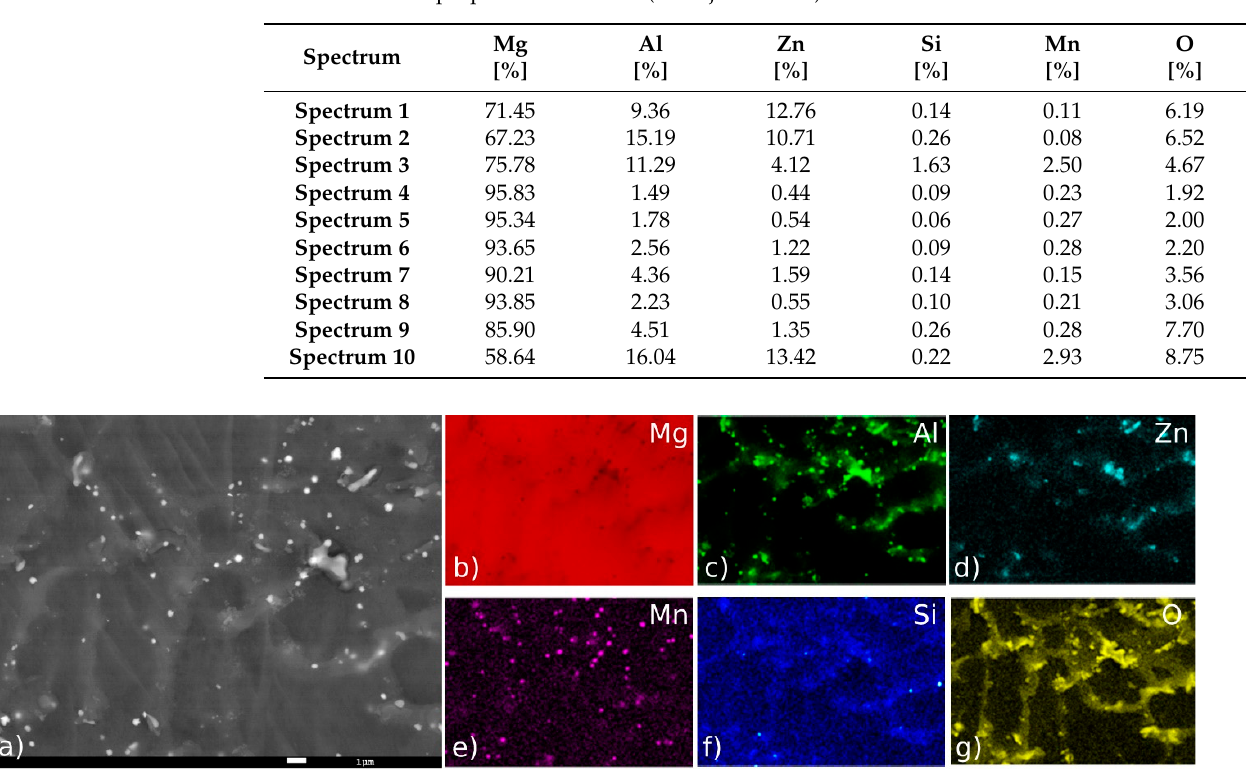
Table 5. Element proportions in wt. % (weld joint No. 1).